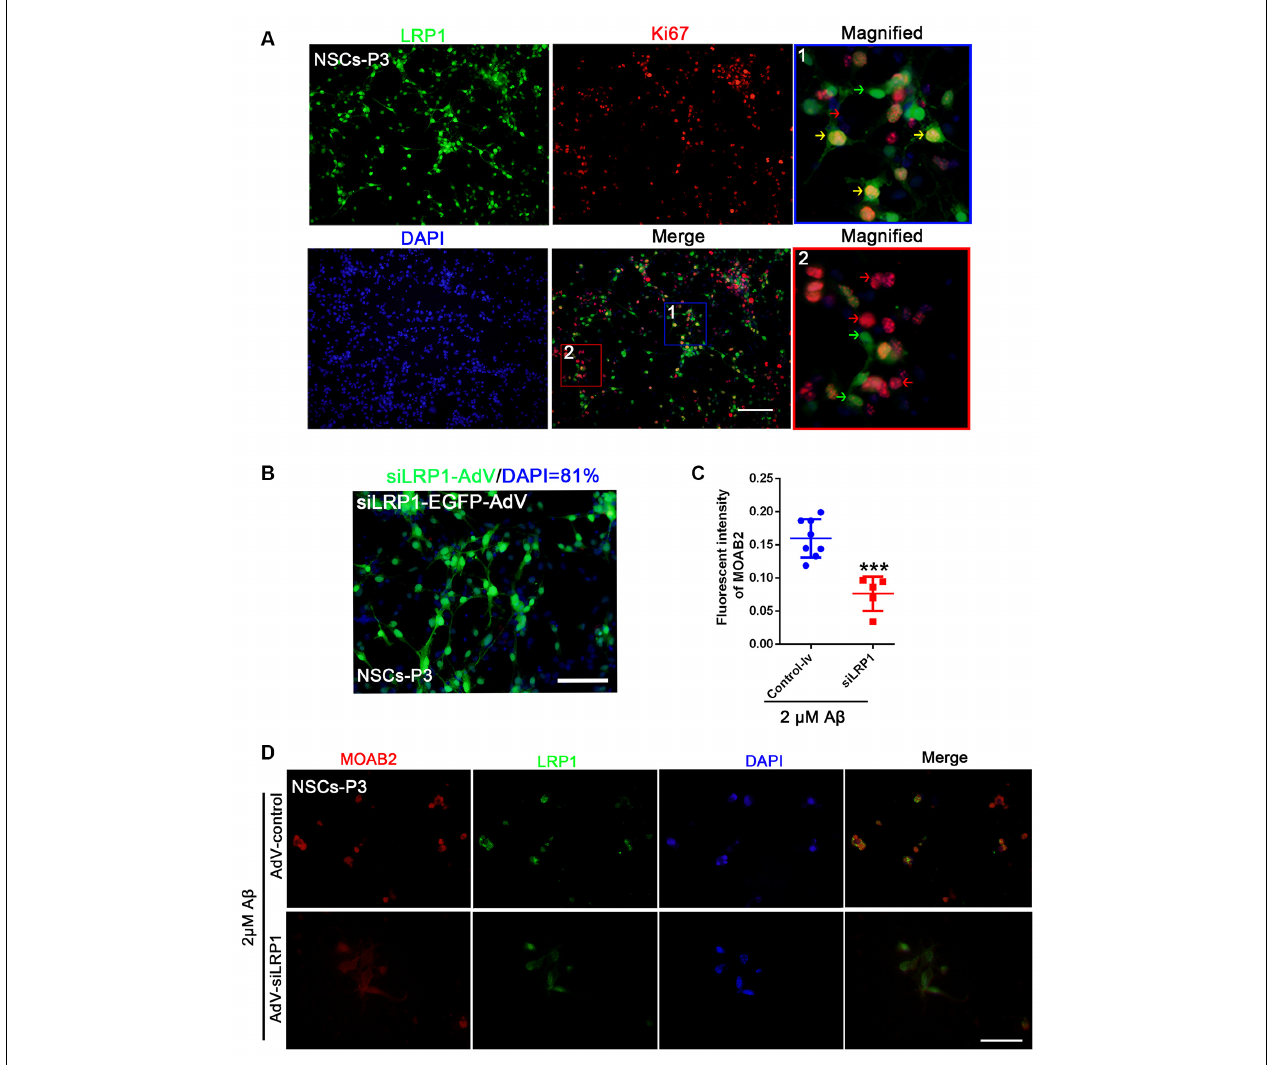
FIGURE 5 | LRP1 is expressed in NSC and regulates the internalization of A β . (A) Immunofluorescence analysis revealing the expression of LRP1 (green) with Ki67 (red) in NSCs. Nuclei were counterstained with DAPI (blue). LRP1 was widely expressed in NSCs (green). Double positive LRP1/Ki67 (yellow arrow), LRP1-negative Ki67-positive NSCs (red arrow), and LRP1-positive Ki67-negative NSCs (green arrow) were also observed. Scale bar = 50 µ m. (B) NSCs were plated in complete medium, and then siLRP1 adenovirus expression using enhanced green fluorescent protein (green) was added (2 × 10 12 ) for 24 h for transfection. The medium was then changed for 48 h. Nuclei were marked with DAPI (blue). The ratio of adenovirus transfection was calculated. (C,D) NSCs were plated in complete medium, and then control-lentivirus and siLRP1 lentivirus were added 24 h for transfection. The medium was then changed for 48 h. Twelve hours after adding 2 µ M A β , fluorescence intensities of MOAB2 and LRP1 were measured and compared. *** represents siLRP1 + 2 µ M A β vs. 2 µ M A β , P < 0.0001. LRP1, low-density lipoprotein receptor-related protein 1; NSCs, neural stem cells; DAPI, 4 (cid:48)